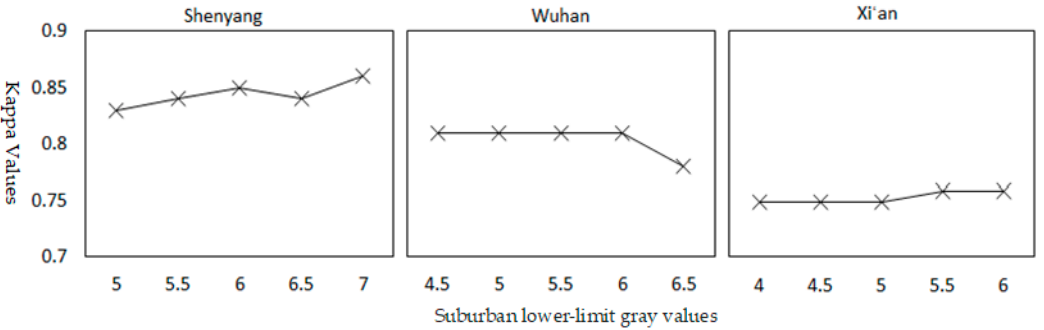
Figure 17. Relationships between the suburban lower-limit gray values and Kappa values.